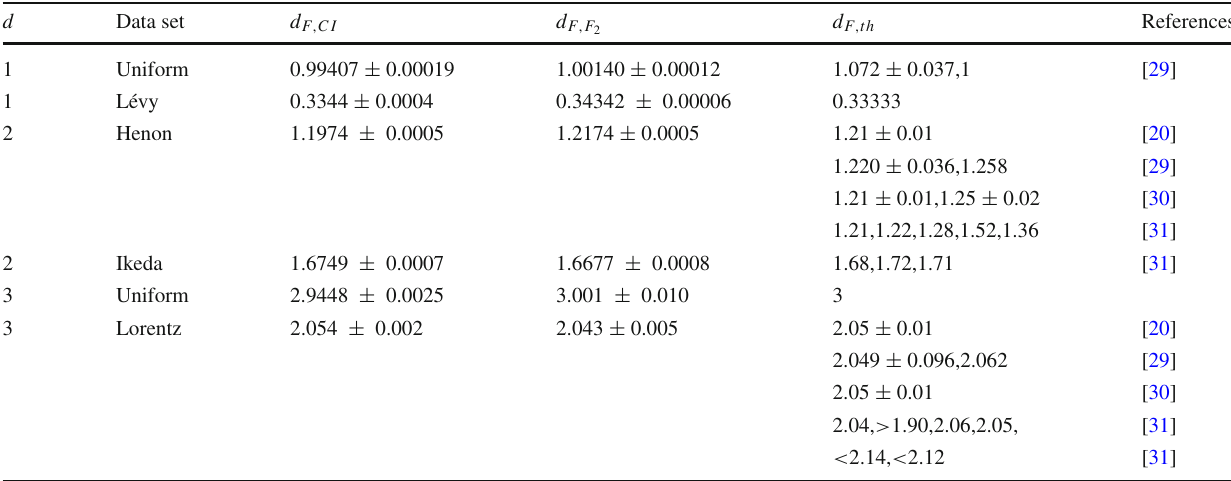
Table 2 Results for the fractal dimension d F calculated by fits on the data depicted on Figs. 6, 7, 8, 9, 10 and 11 between the slashed lines. d F , CI are extracted by fits on the C r data in graphs b and d F , F